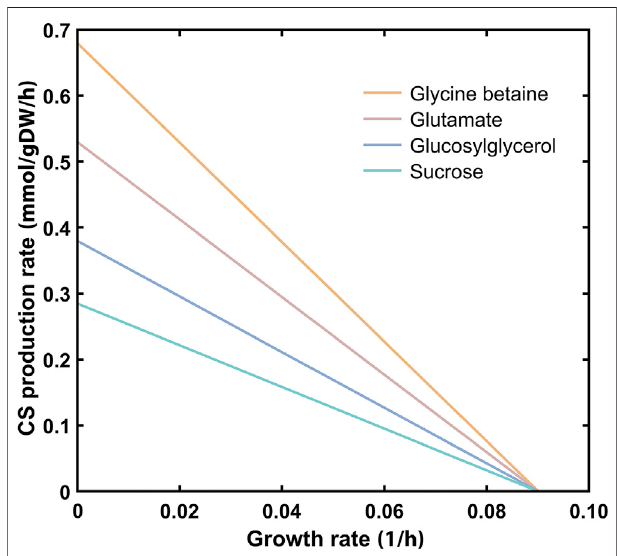
FIGURE 4 | Theoretical productivity of the heterologous compatible solute glycine betaine and the native ones (glutamate, glucosylglycerol, and sucrose), as predicted by the updated version of the genome-scale metabolic model i Syn811. The lines represent the compatible solute production rate as a function of Synechocystis wild-type growth under autotrophic conditions.